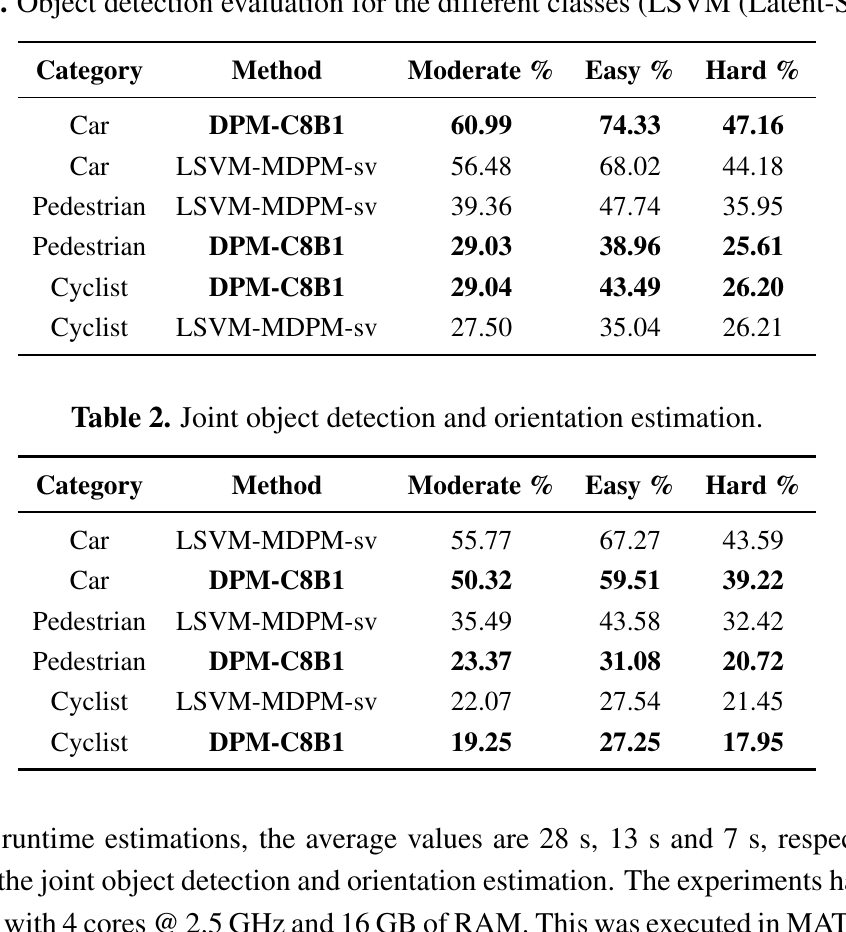
Table 1. Object detection evaluation for the different classes (LSVM (Latent-SVM)).